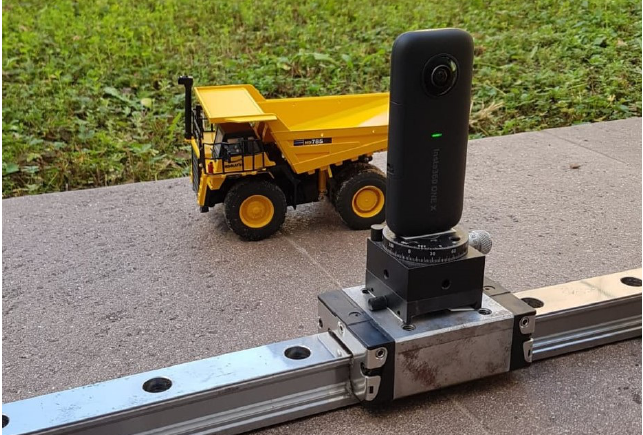
Figure 8. Experimental setup to test the developed algorithm. A 360° camera is placed on a rotary and a translation stage. The camera frames the miniature model of a